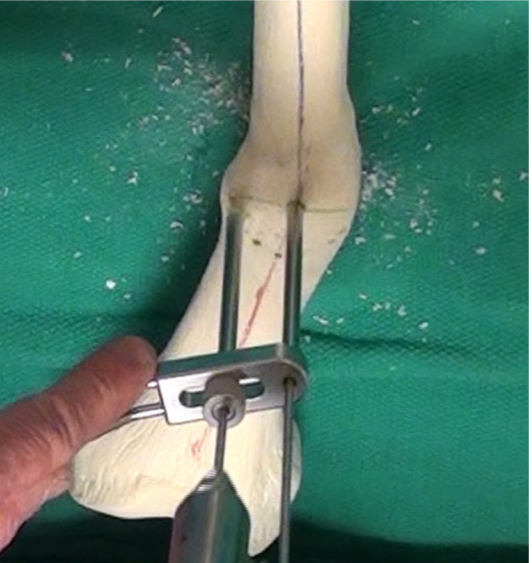
Figure 3. Execution of the focal dome osteotomy. A central reference drill bit is placed at the CORA. A parallel drill guide is set to the desired width, and a second drill bit is used to drill parallel holes in the bone along the arc achieved by rotating around the reference bit. Supplementary Video S1 accompanies this image.